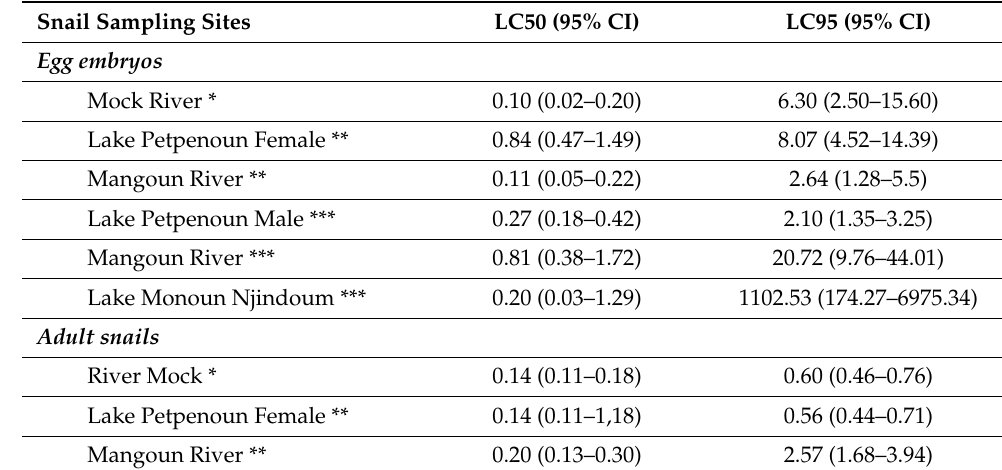
Table 2. Lethal concentrations ( LC50 and LC95 ) of egg embryos and adult snails to Niclosamide (Bayluscide WP 70) according to sampling sites and